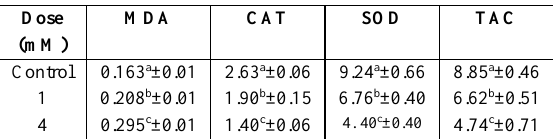
Table 5. The mean of total antioxidant capacity (TAC) (μg/mL) and malondialdehyde (MDA) (μM/mL) as well as activity of catalase (CAT) (Unit min-1 mg-1 protein) and superoxide dismutase (SOD) (Unit min-1 mg-1 protein) in the differentiated cells treated with DEA for 21